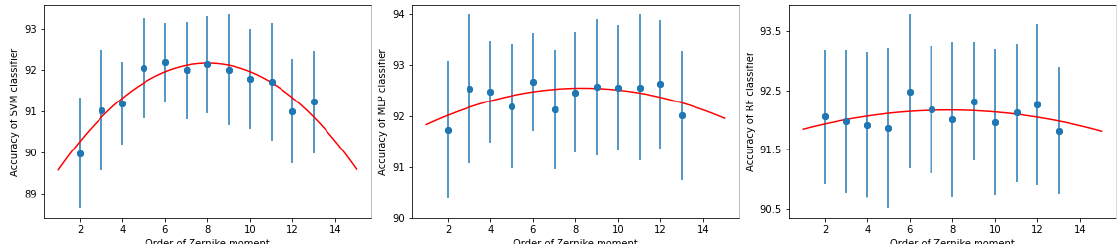
Figure 4. Dependence of the total accuracy on the maximum order of the Zernike moment for SVM ( left column ), MLP ( middle column ) and RF ( right column ). Error bars represent the standard